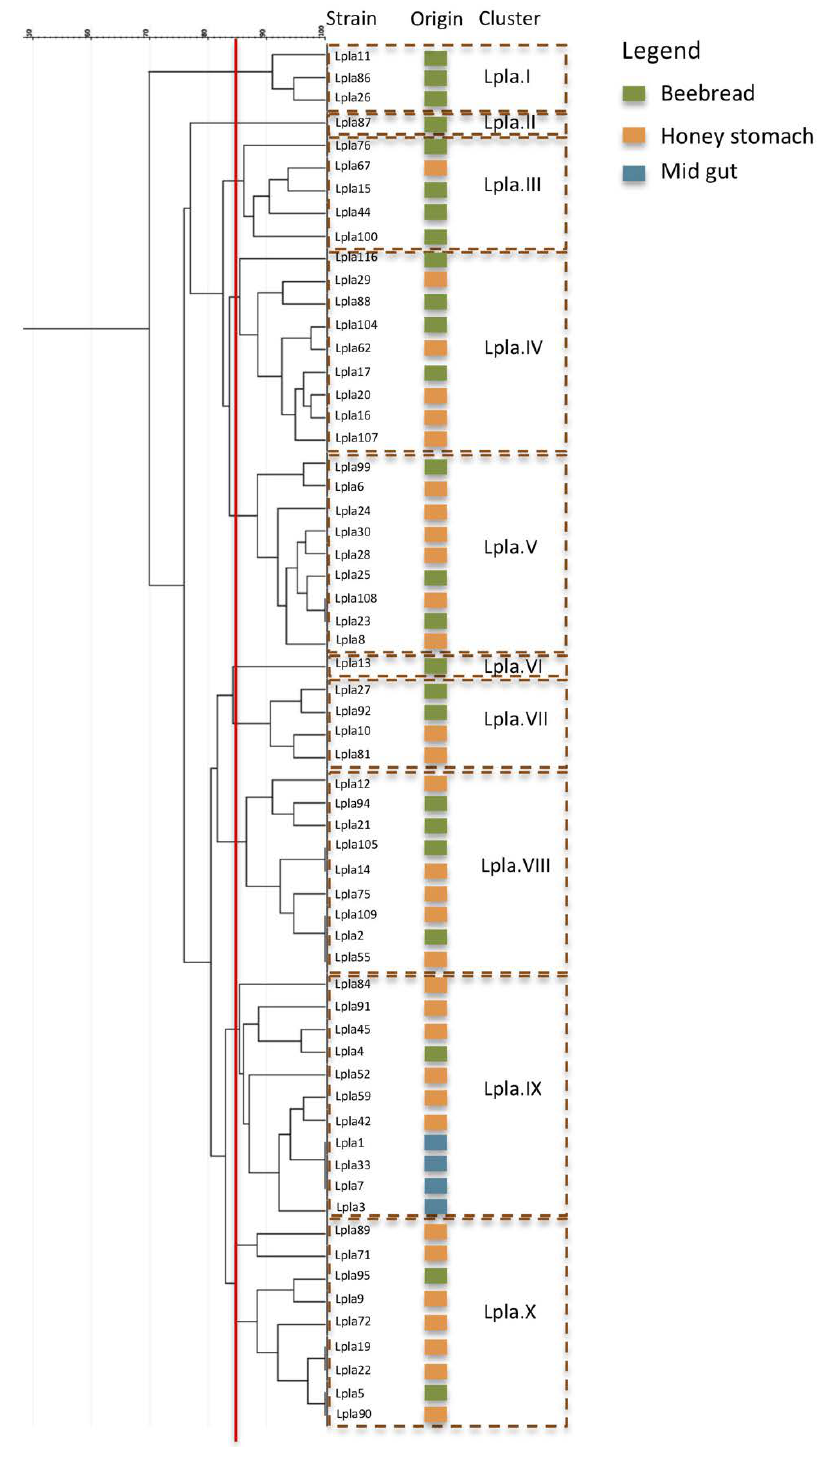
Figure 4. Cluster analysis based on the RAPD-PCR profiles of the 61 strains belonging to Lactiplantibacillus plantarum. Vertical red line indicates the threshold value (85%). F. fructosus strains, isolated from beebread and honey stomach, as reported in Figure 5, were grouped into three clusters (Ff.I, Ff.II, Ff.III). Cluster Ff.III showed strains from both environments, while clusters Ff.I and Ff.II grouped only strains isolated from beebread. Even if distinct clusters were detected, it should be considered that the number of samples (isolates) for this species is much lower than for the previous species ( Al. kunkeei , Lp. plantarum ).